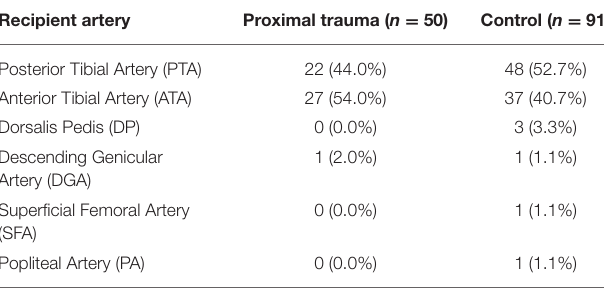
TABLE 3 | Choice of recipient artery for free flap.